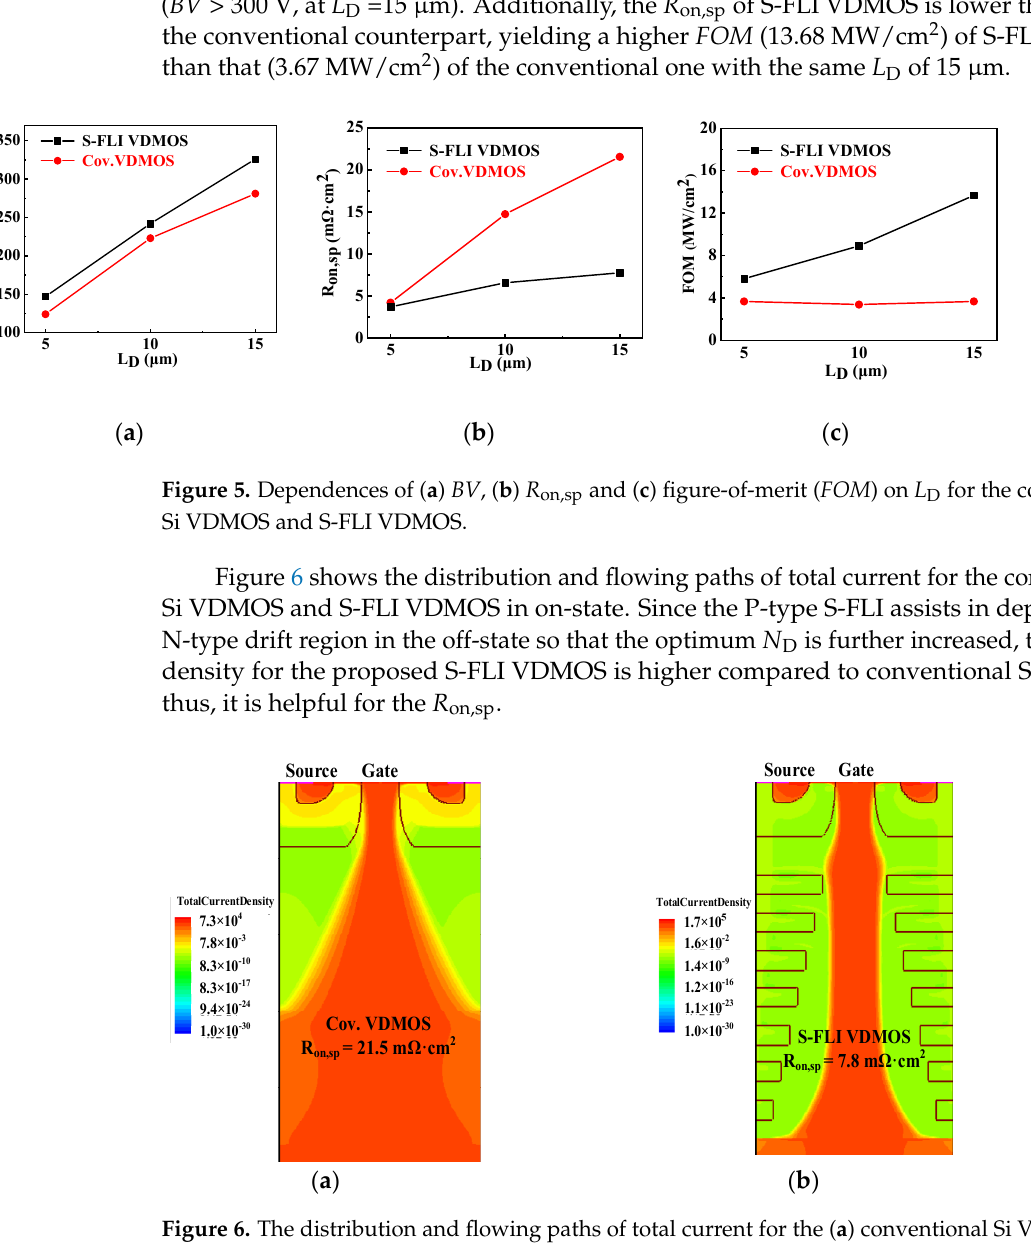
Figure 4. Dependences of ( a ) BV and ( b ) R on,sp on Rings values and L D for S-FLI VDMOS.